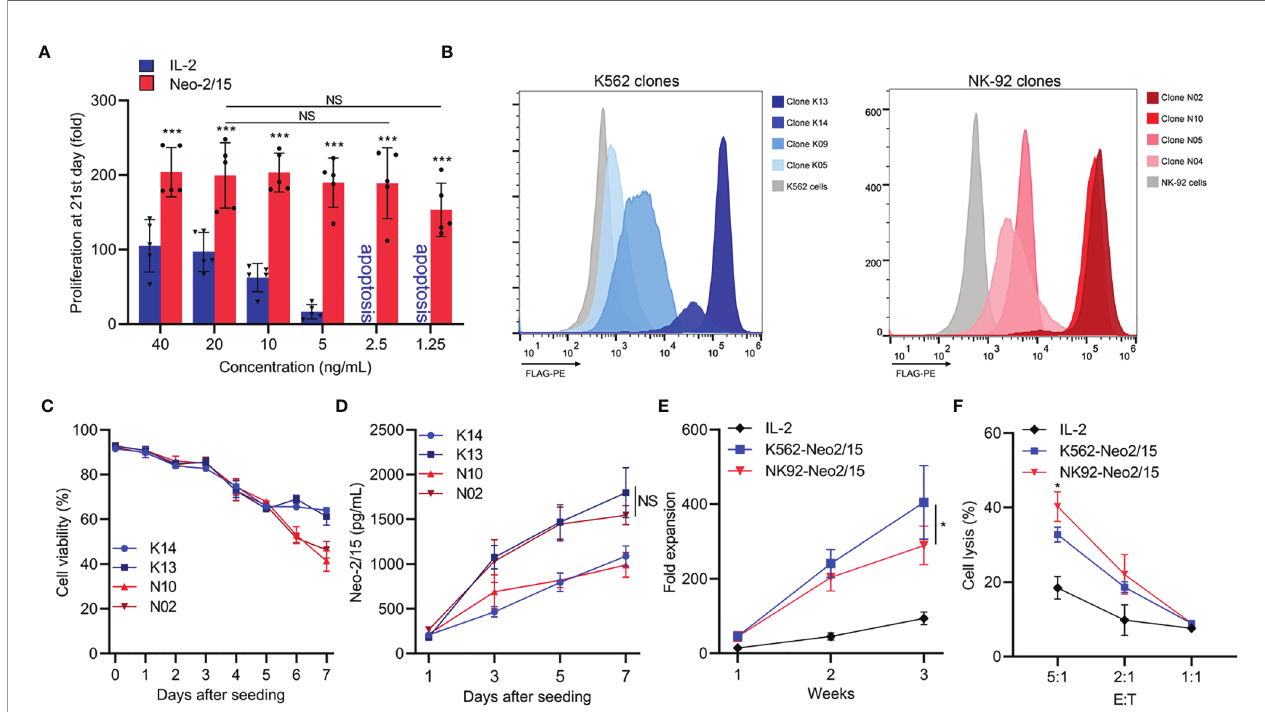
FIGURE 1 | Generation and characterization of feeder cells expressing secretory Neoleukin-2/15 (*p<0.05, ***p<0.001; NS indicates no signi fi cant difference). (A) In vitro expansion of the NK cells from 5 volunteers by IL-2 or Neo-2/15 at the indicated concentration. (B) Genetically Engineered K562 or NK92 clones expressing secretory neoleukin-2/15 were analyzed by fl ow cytometry. (C) The survival of irradiated clones cultured in AIM-V medium and examined over one week. (D) Neo-2/ 15 secretion by indicated clones was measured. (E) NK cells were co-cultured with irradiated K562-Neo2/15 or NK92-Neo2/15, cell expansion fold was measured. (F) Cytotoxicity assay to measure NK-mediated cell killing in Raji cell at indicated effector-to-target